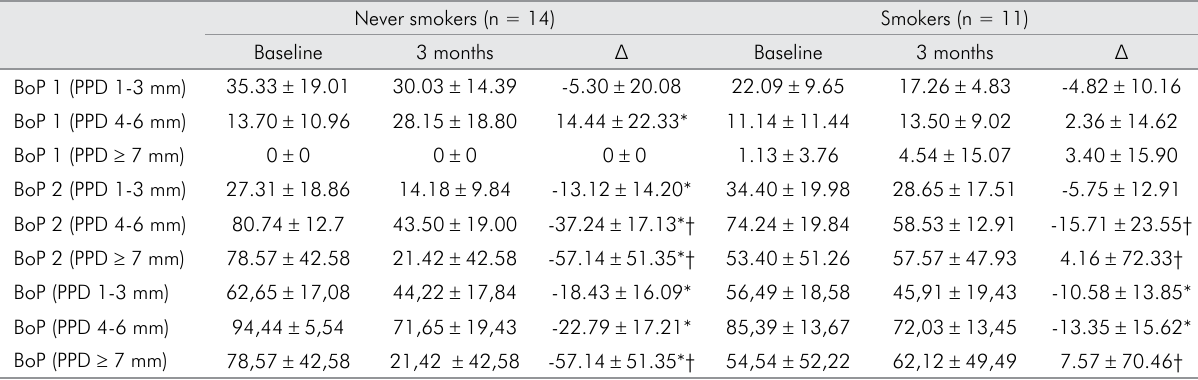
Table 3. Mean ( ± SD) BoP values according to PPD categories at baseline and 3 months as well as BoP mean alterations ( Δ